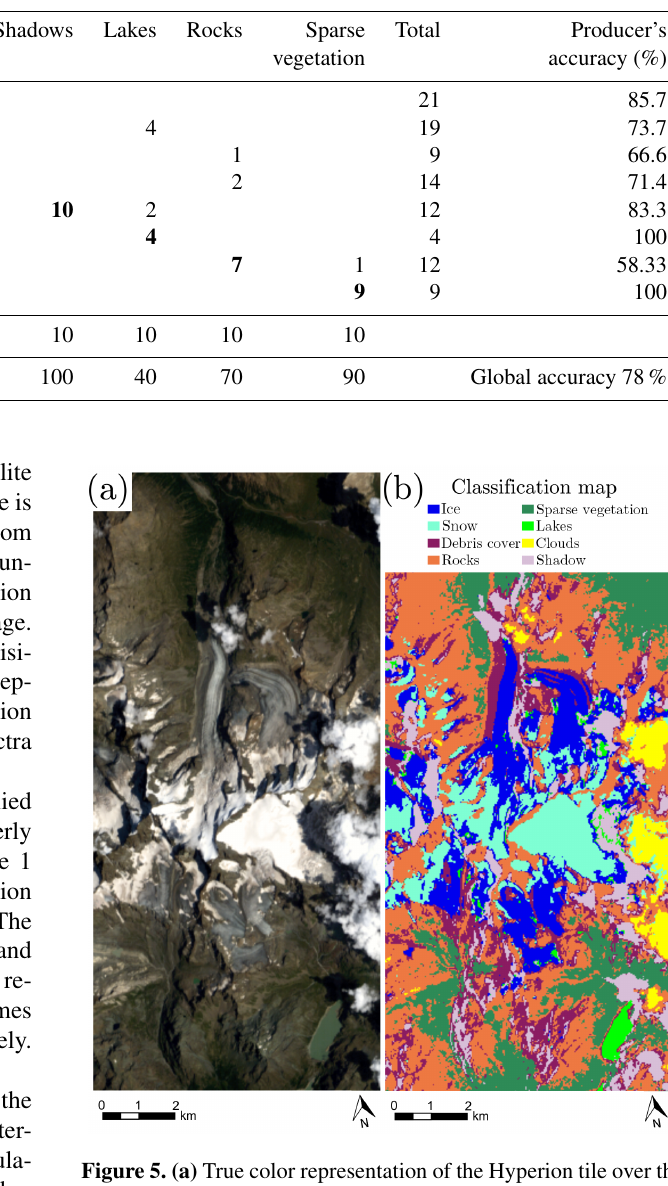
Table 1. Confusion matrix obtained from the validation scheme of the support vector machine (SVM) classification of Hyperion data. Rows represent the true classes, and columns represent the predicted classes. User and producer accuracies are reported for each class. Global accuracy is also displayed.